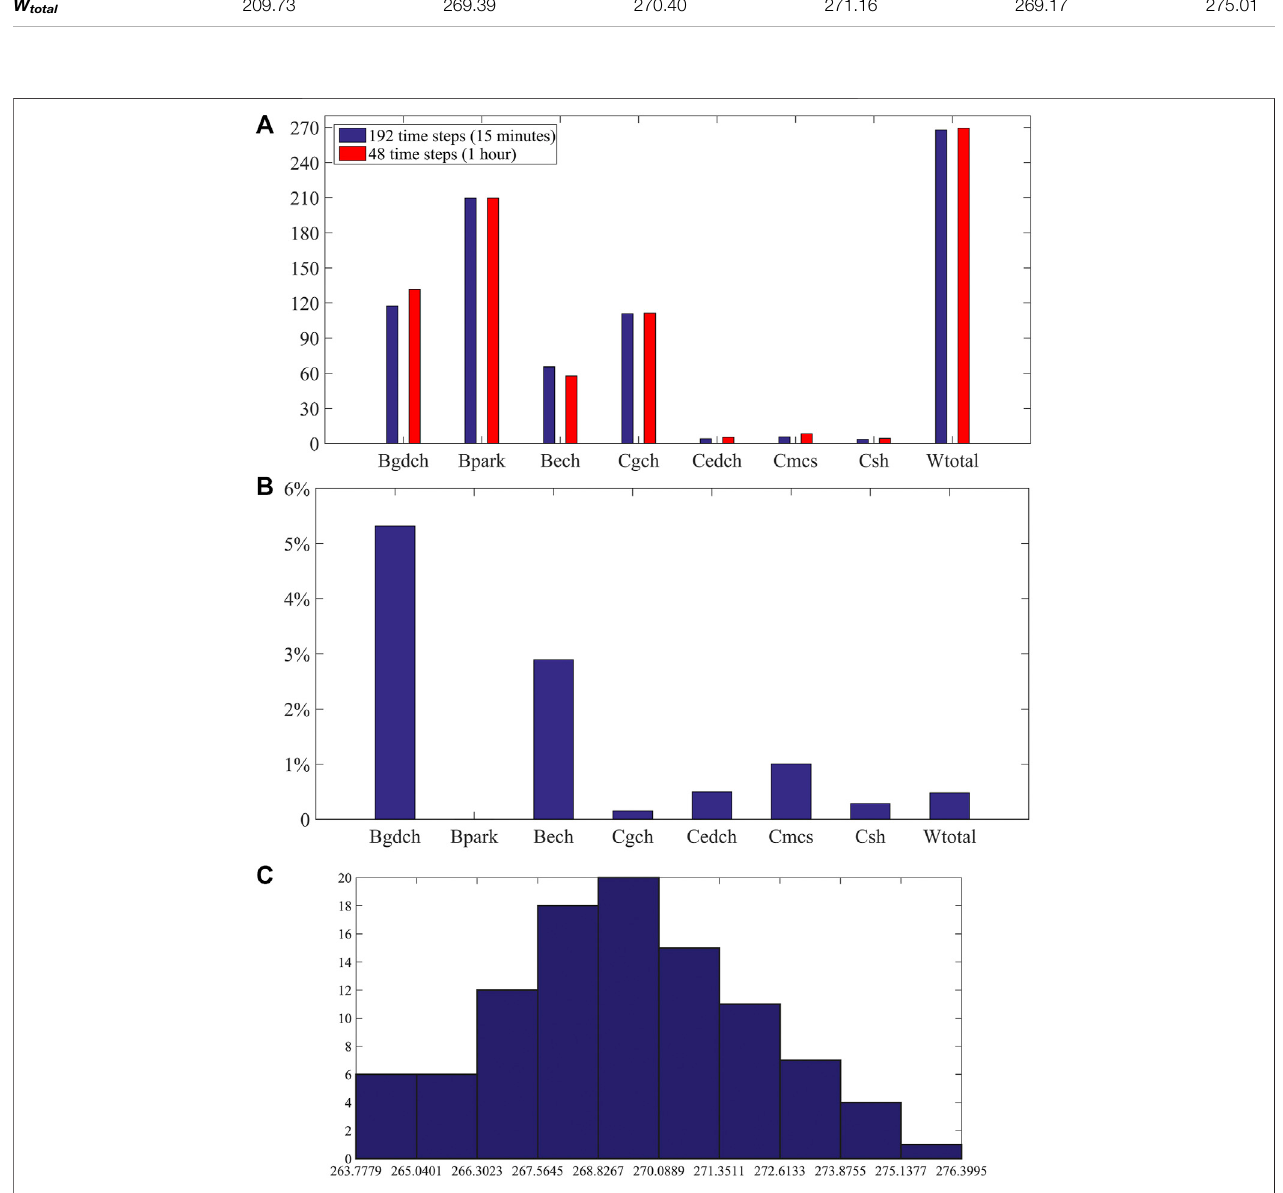
FIGURE 2 | (A) The values of the parking pro fi t functions in strategy 1. (B) The percentage of changes in parking functions relative to W total . (C) Diagram of the frequency distribution of parking lot pro fi t ( € ) in strategy 1.